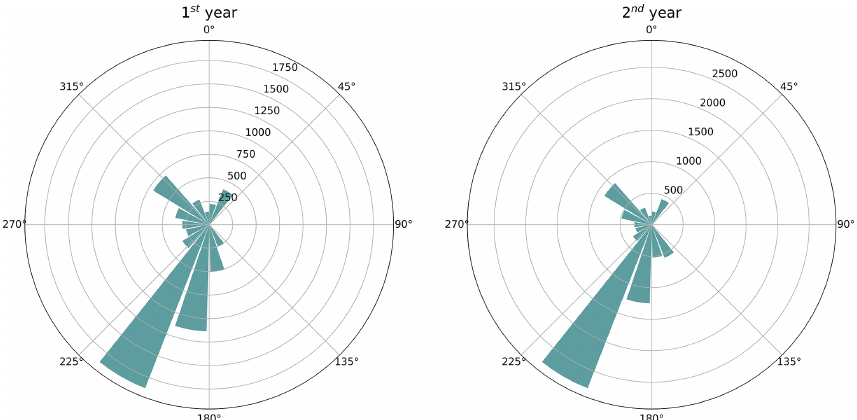
Figure 2. Number of accepted flux measurements within 20 ◦ sectors around the flux tower during the first and second years. Data from 30 to 140 ◦ were